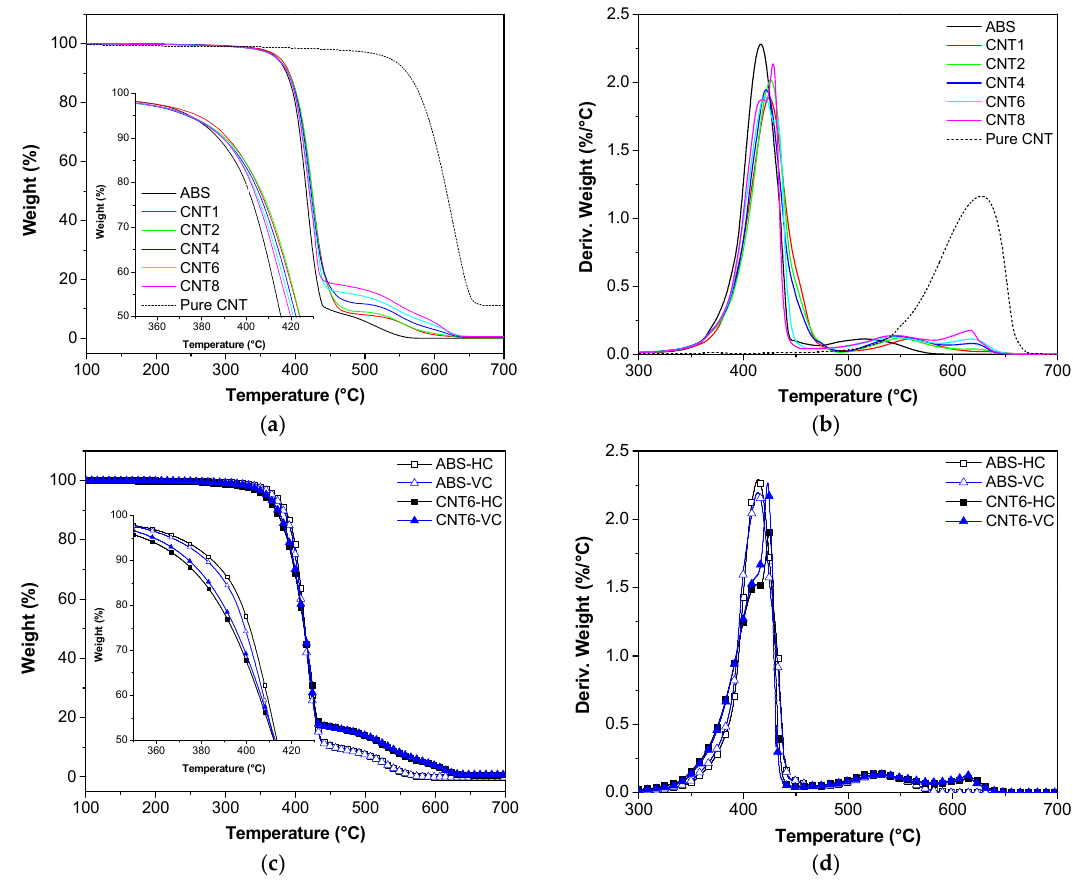
Figure 6. TGA curves of neat and nanofilled ABS filament and 3D-printed samples (HC and VC) under air atmosphere: ( a , c ) Residual mass as a function of temperature; ( b , d ) Derivative of the mass loss. Table 4. TGA data of pure ABS and its nanocomposites in an air atmosphere.